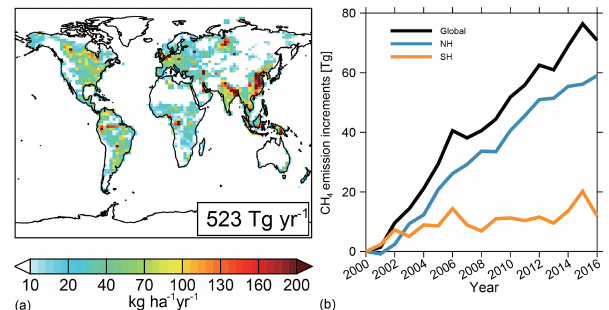
Figure 1. Spatial distribution of global CH 4 emissions averaged be- tween 2000 and 2016 (a) and a time series of CH 4 emissions relative to year 2000 emissions (482Tg CH 4 a − 1 ) (b) for the globe (black line), Northern Hemisphere (NH, blue line), and Southern Hemi- sphere (SH, orange